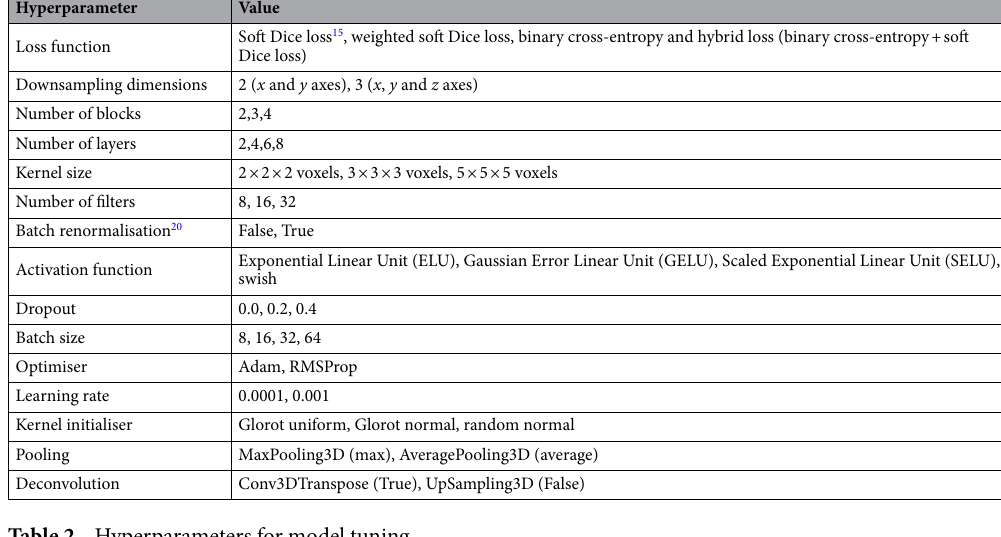
Table 2. Hyperparameters for model